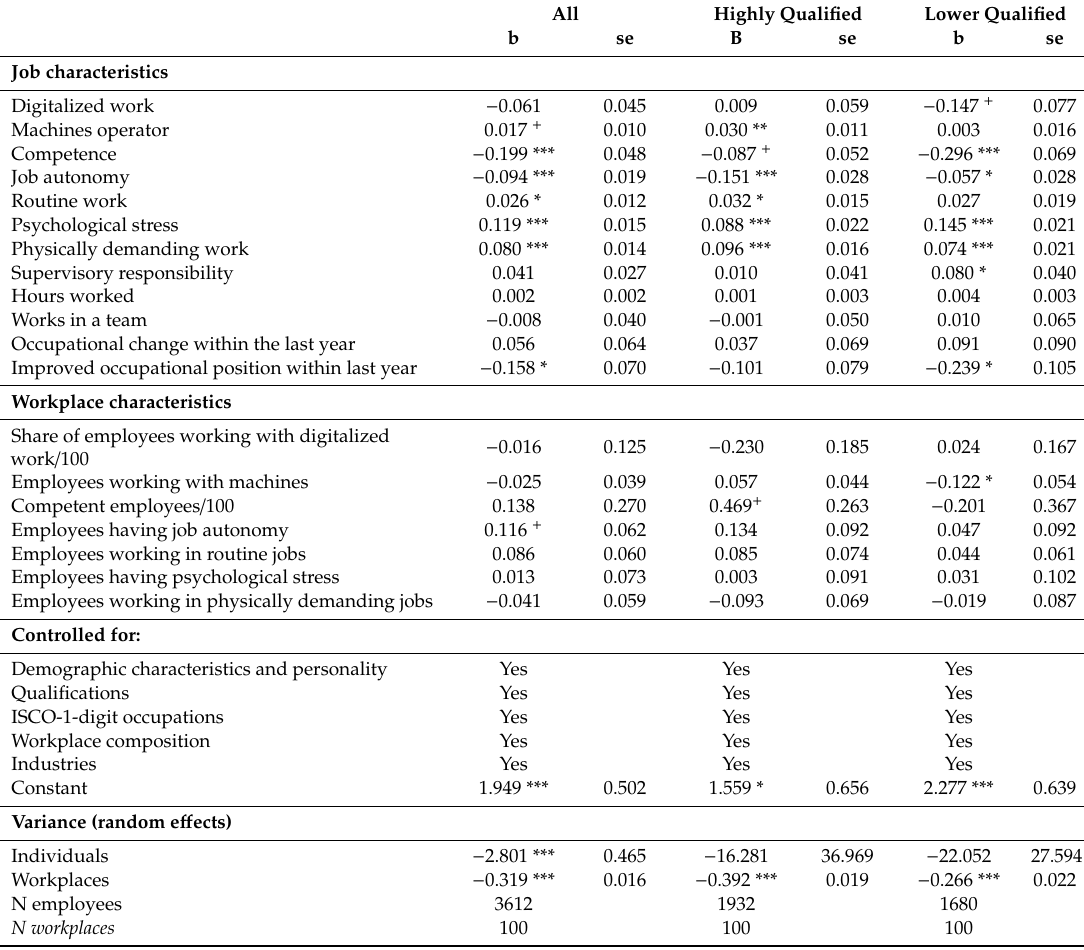
Table 4. Influence of digitalized work and other job characteristics at the individual and workplace level on coworker bullying (workplace level random effects regressions).